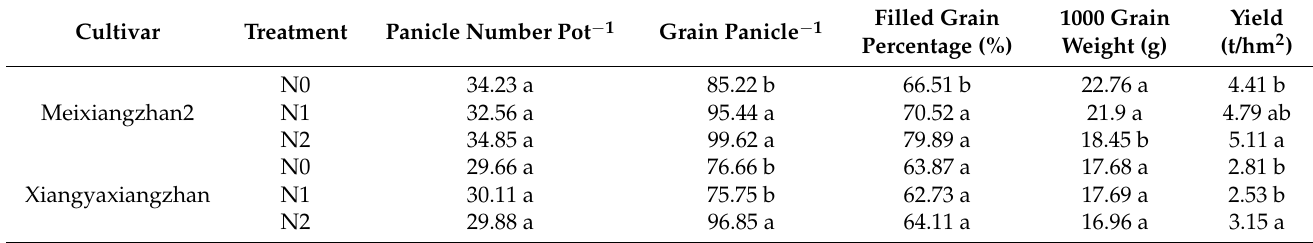
Table 3. Effect of N treatments on yield and yield-related traits. Cultivar